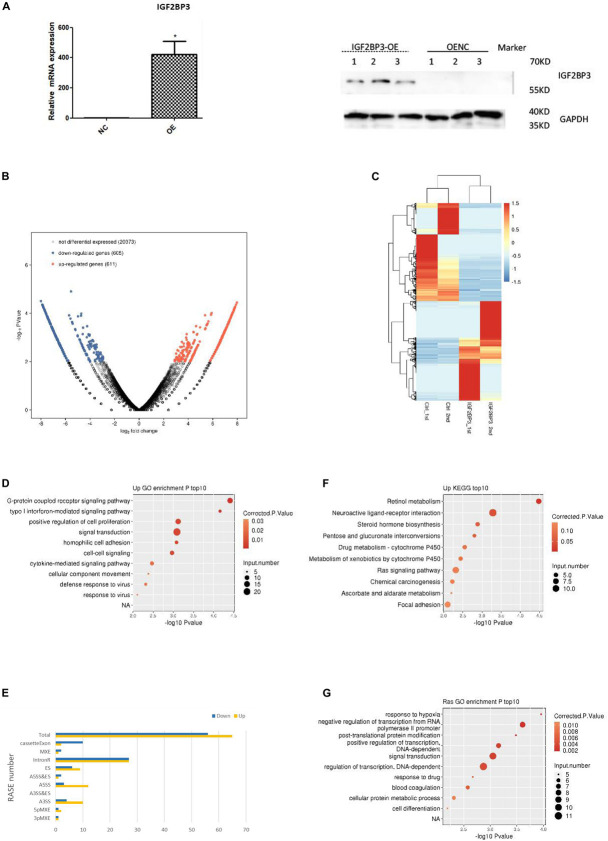
IGF2BP3 regulates multiple alternative splicing events. (A) IGF2BP3 expression on mRNA and protein level in A549 cells after transiently transfected with IGF2BP3 specific overexpression RNA or control vector, as determined by qRT-PCR and Western blot analysis. (B) Total number of differentially expressed genes. (C) Hierarchical clustering of DEGs in overexpressed and control samples. Expression values (FPKM) are log2-transformed and then median-centered by each gene. (D,E) The top 10 representative GO Biological Process terms of IGF2BP3-regulated genes. (F) Classification of different AS types regulated by IGF2BP3 protein. (G) The top 10 GO Pathways for gene aggregation of differential AS events.